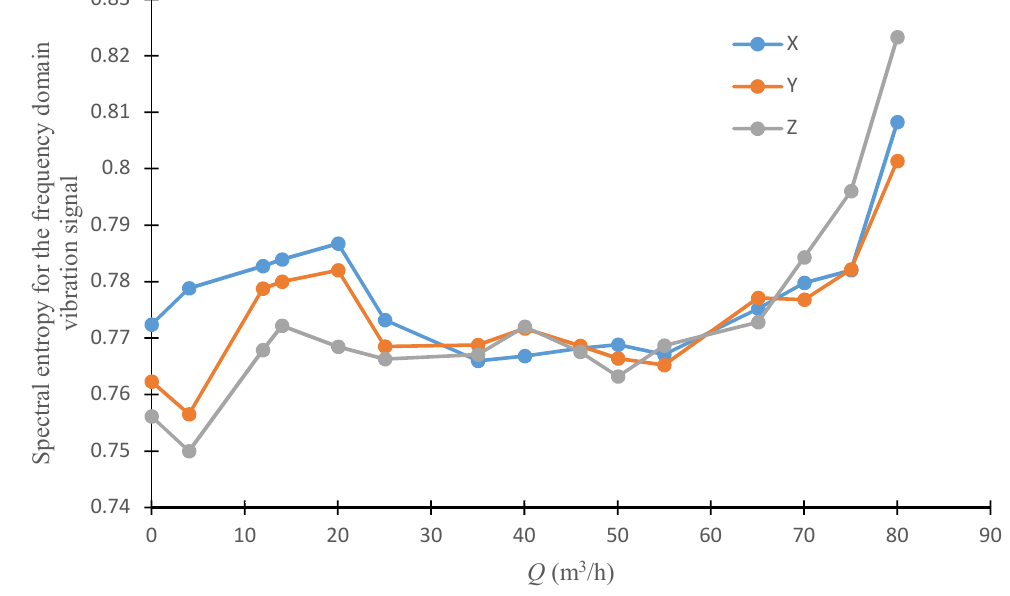
Figure 19. Spectral entropy for the different direction frequency domain vibration signal under different flowrates.